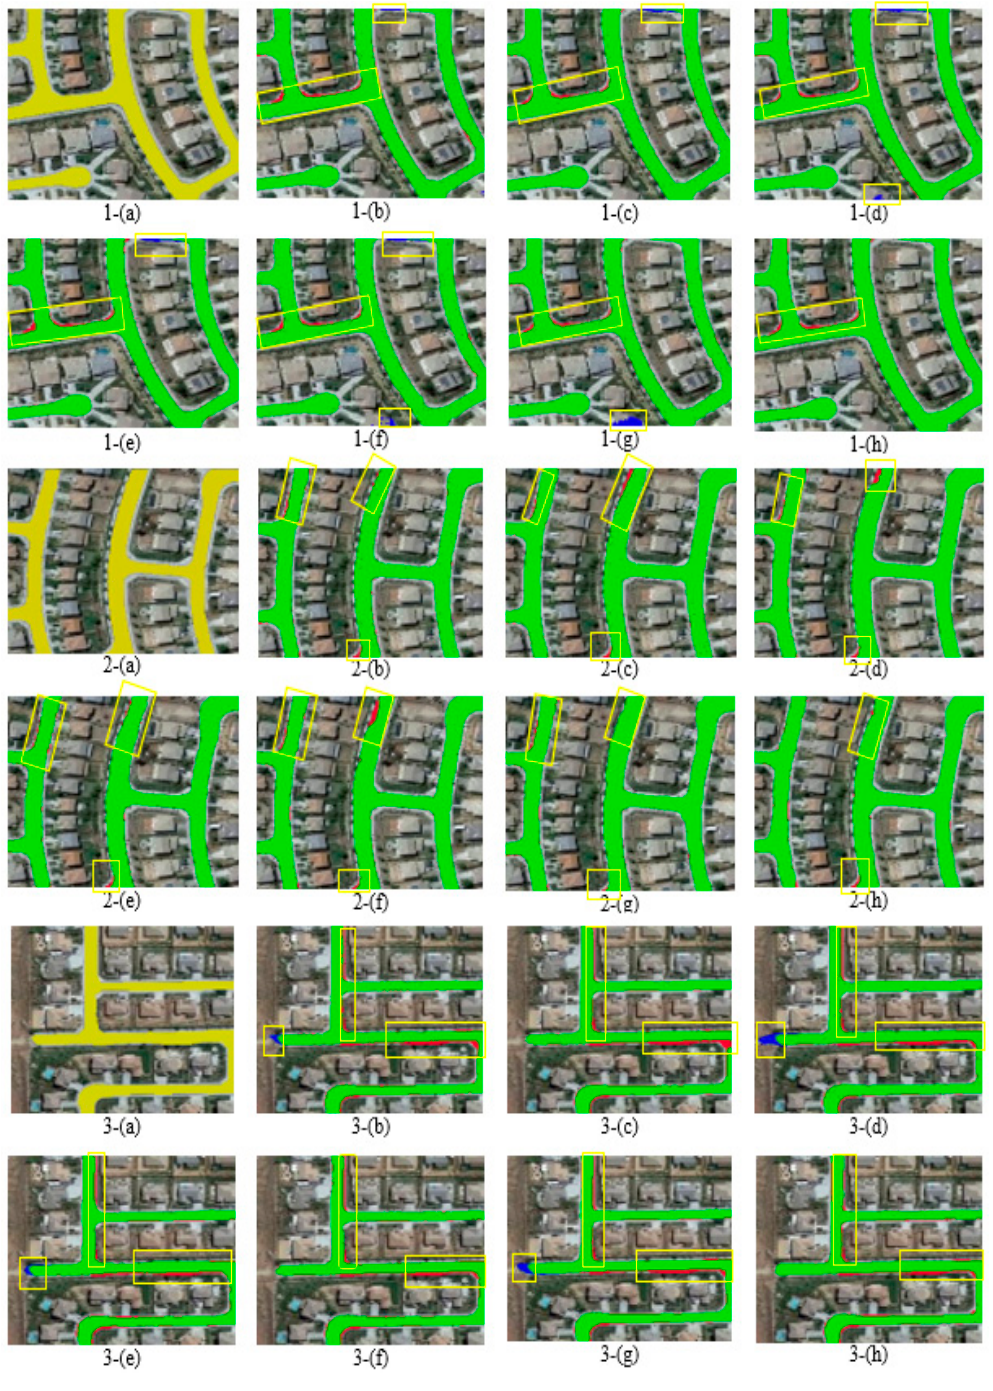
Figure 3. Visual comparisons for road extraction by ( a ) original image with the corresponding ground truth, ( b ) cascaded net, ( c ) RCNN2, ( d ) RCNN3, ( e ) proposed model in Figure 2A, ( f ) proposed model in Figure 2B, ( g ) proposed model in Figure 2C, and ( h ) proposed model in Figure 2D. Green, red and blue represents TP, FN, and FP, respectively. In images 1-(b–h), shown in Figure 3, false negative pixels (red color) are found near the intersections. The false positive pixels (blue color) in images 1-(b–f) of Figure 3 are found in the upper part of the images. In images 1-(g) and 1-(h) of Figure 3, the two models